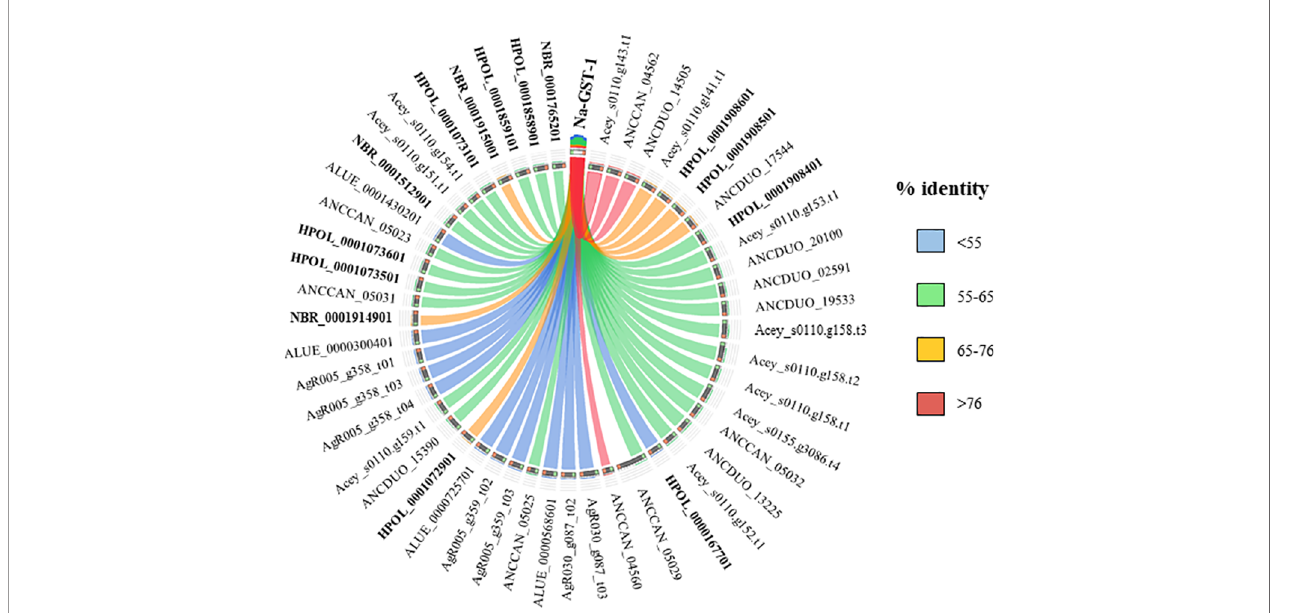
FIGURE 3 | Similarity plot. Circos plot generated using Circoletto (Darzentas, 2010) showing the percentage of identity between Na-GST-1 and their homologues in different rodent model nematodes. Only homologues with e-values < 1E-50 are shown. Protein names as per Parasite WormBase database (v.15) have been used for comparison. ALUE, Ascaris lumbricoides ; AgR, Ascaris suum ; ANCCAN, Ancylostoma caninum ; Acey, Ancylostoma ceylanicum ; ANCDUO, Ancylostoma duodenale ; HPOL, Heligmosomoides polygyrus ; NBR, Nippostrongylus brasiliensis ; TMUE, Trichuris muris ; TTRE, Trichuris trichiura